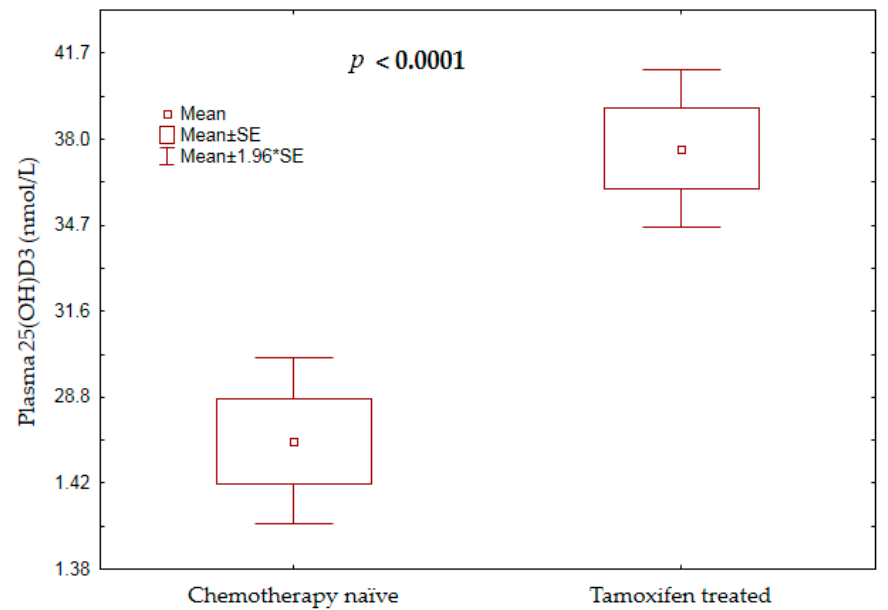
Figure 2. Comparison of mean plasma 25(OH)D 3 concentrations between chemotherapy-naïve patients and those on tamoxifen treatment.